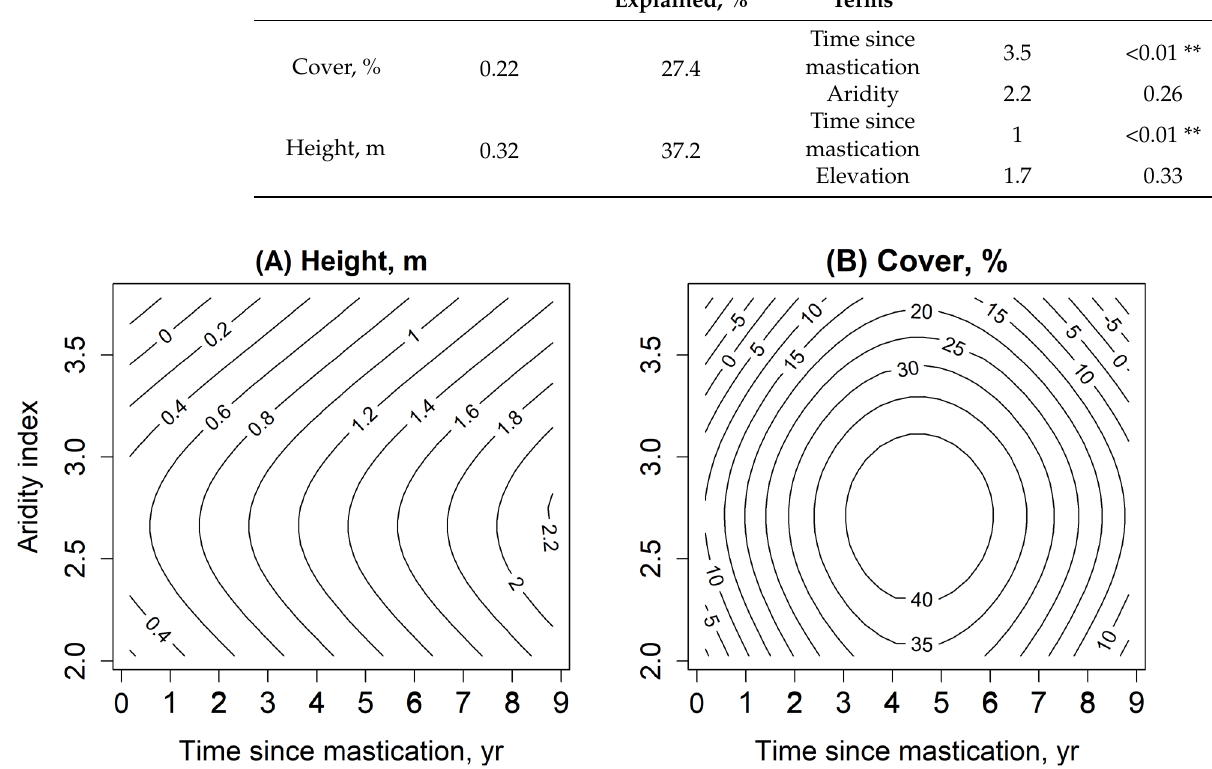
Figure 5. Contour plot showing properties of standing fuel as a function of time since mastication and aridity as predicted by the GAM for: ( A ) standing fuel height; and ( B ) standing fuel cover. Table 3. Diagnostics of the GAMs fitted to the standing fuel properties with time since mastication and aridity as smoothed predictor variables. e.d.f. = effective degrees of freedom. Statistical signifi- cance denoted by ** p <0.01. Model